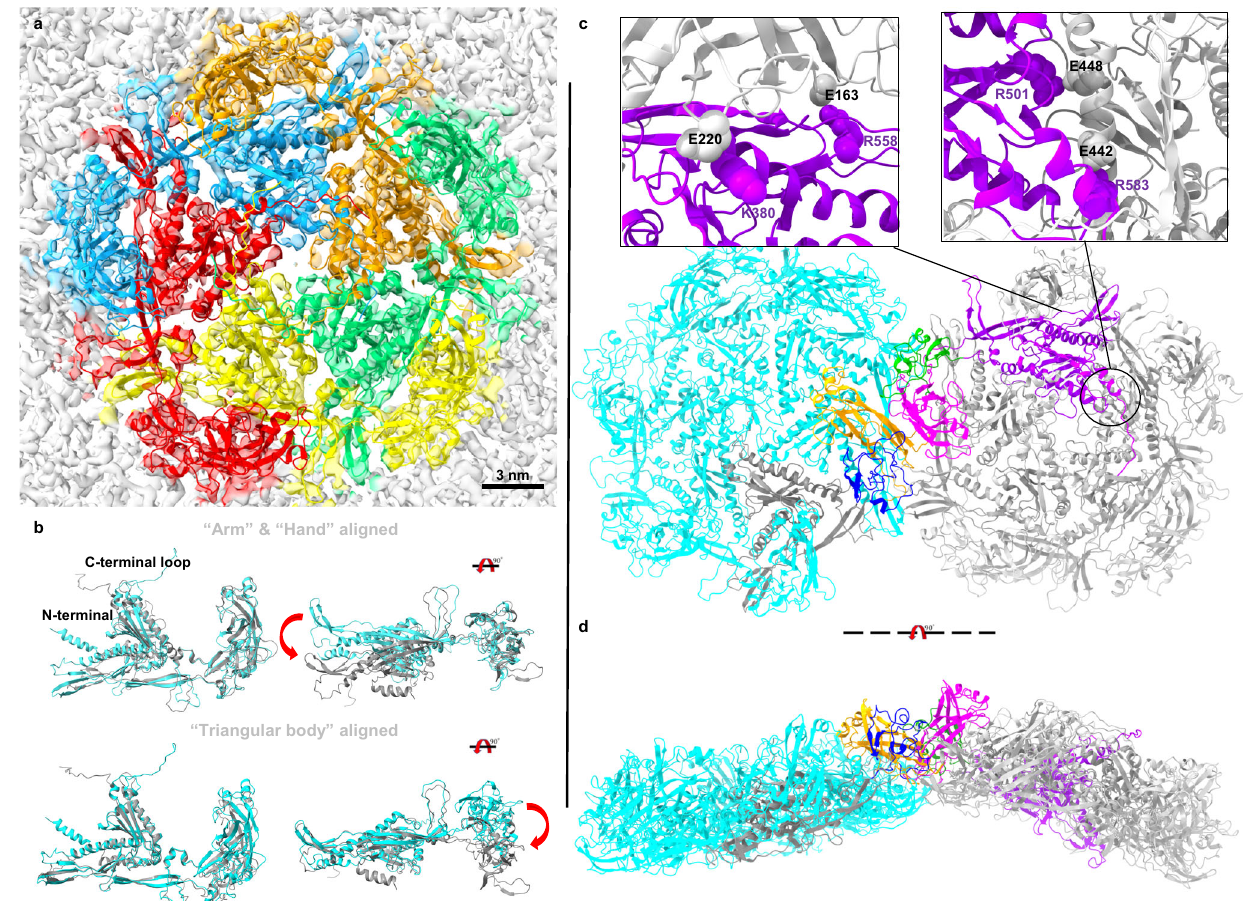
Fig. 2 | Pentamer arrangement in the capsid of ϕ Kp24. a Top view of a penta- meric capsomere. Five gp372 structures were fi tted into the density map and colored differently. Compared with the hexamer, the pentamer lacks a structured poreatthecenter.EachC-terminalloopis fl exible,andittendstomovetothearea closertoanothergp372 ’ shand. b StructuralcomparisonbetweentheMCP(cyan)in a hexamer and MCP (gray) in a pentamer. There are some differences, such as the C-terminalloop, the N-terminal α helix,and the pendulum angle(upperred arrow) of twotriangularbodies(alignedhandand arm),orthependulumangle(lowerred arrow) of two hands (aligned triangular body). The right image in b shows the comparison after rotation of the left structure by 90°. c Pentamer-hexamer inter- actions. The interactions between a pentamer (gray) and a neighboring hexamer